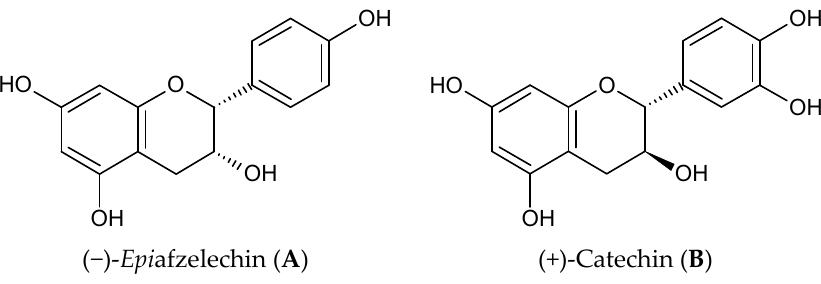
Figure 1. Chemical structure of ( − )- epi afzelechin ( A ) and (+)-catechin ( B ).